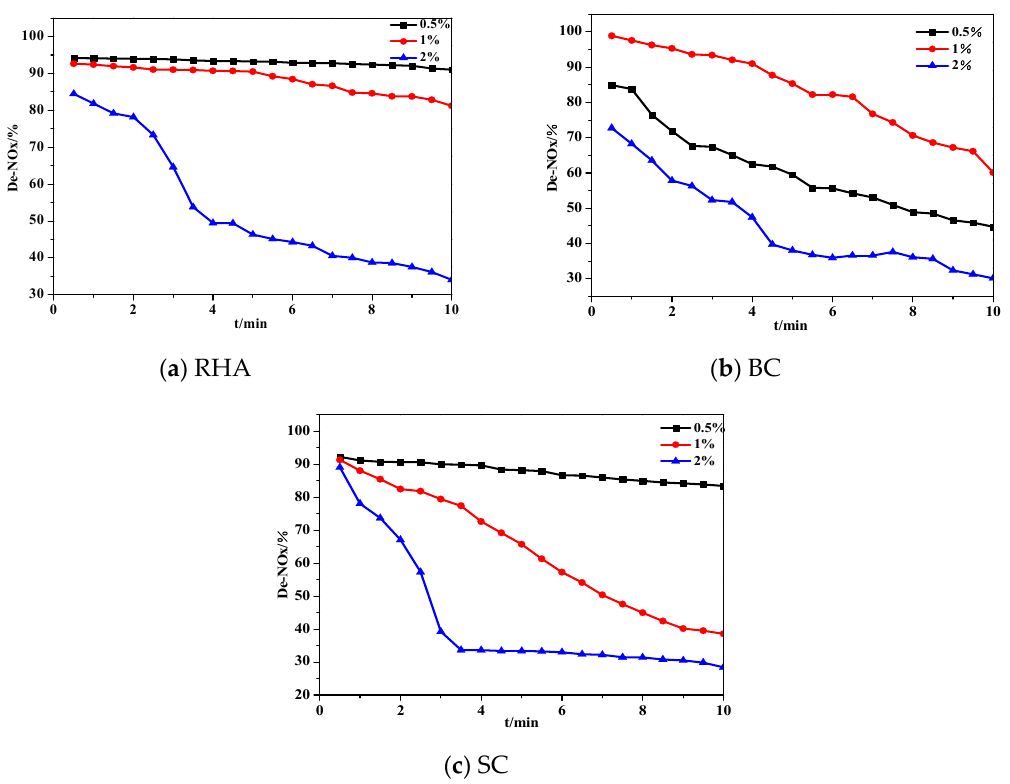
Figure 4. Effect of O 2 concentration on the denitration rate of ( a ) RHA, ( b ) BC, ( c ) SC. Table 2. Optimum reaction conditions and denitration rate of carbon materials.